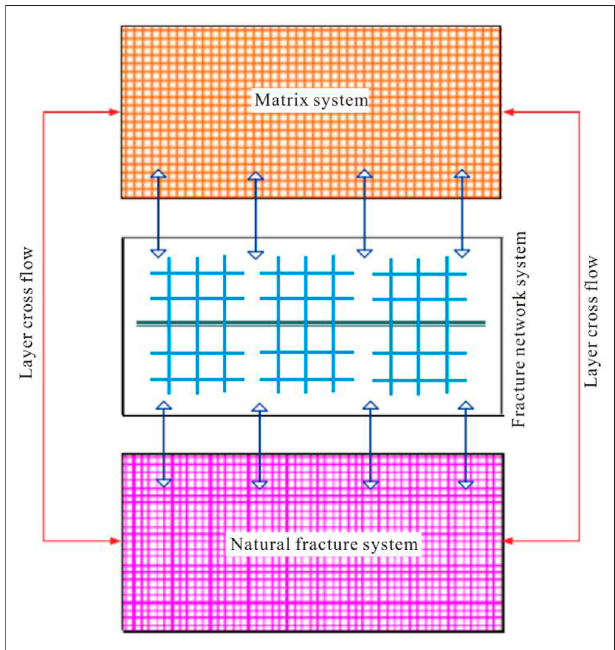
FIGURE1| Schematicdiagramofthephysicalmodelofvolumefracturing based on multi-porous media model (Modi fi ed after Ren et al., 2019).